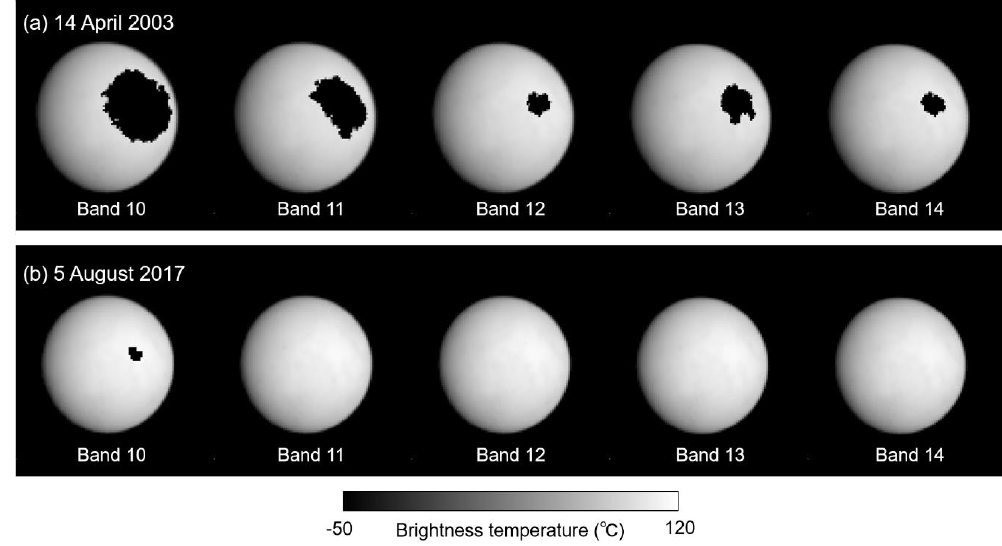
Figure 8. Observed images of the Moon in ( a ) 2003 and ( b ) 2017. The oversampling effects were corrected by averaging pixels whose field of views overlapped. The black pixels in the lunar disk represent regions where at least one pixel in the original image was saturated when averaging.